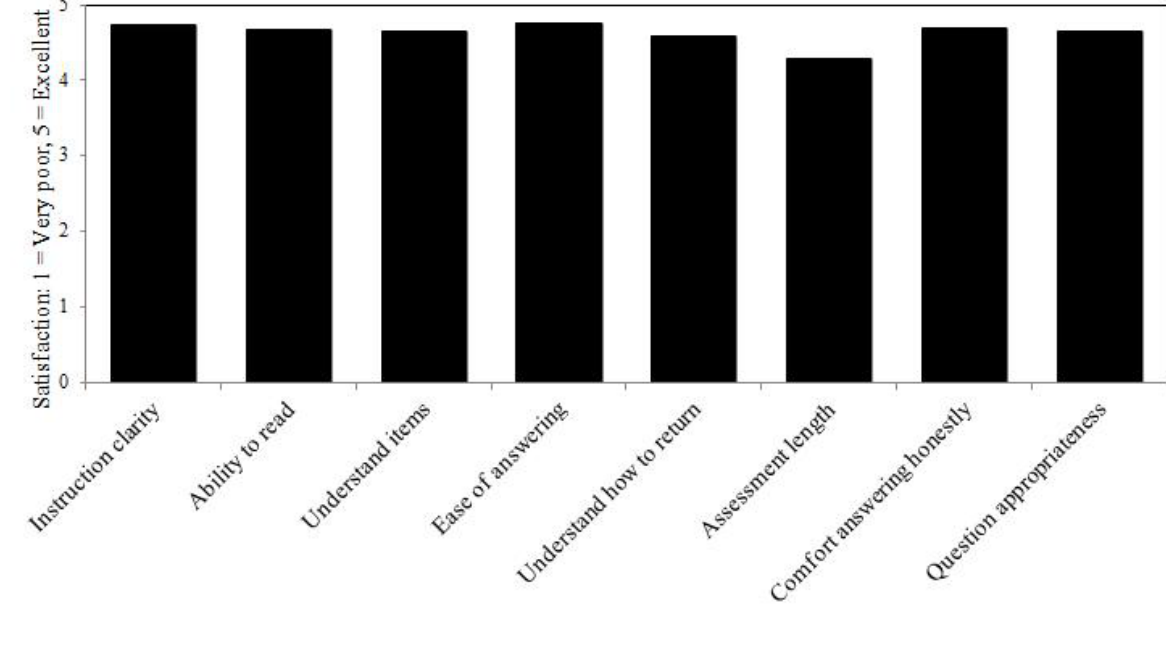
Figure 7. Mean CABIT assessment satisfaction scores for patients (n = 67). The target satisfaction score was 4.00